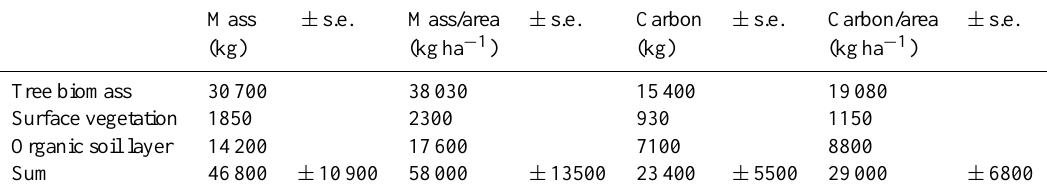
Table 1. Estimated amount of burned organic material during the experiment. s.e. = standard error of the estimate. Mass ± s.e. Mass/area ± s.e. Carbon ± s.e. Carbon/area ± s.e. (kg) (kgha − 1 ) (kg) (kgha − 1 ) Tree biomass 30700 38030 15400 19080 Surface vegetation 1850 2300 930 1150 Organic soil layer 14200 17600